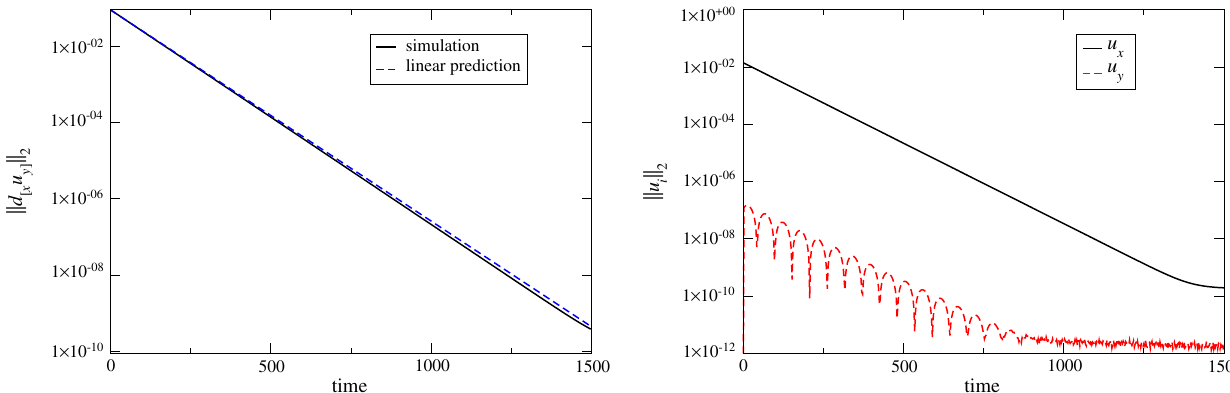
FIG. 4. L norms of (a) vorticity and (b) u 2 ¼ 10 7 , v ¼ 0 : 02 , D ¼ 10 , n ¼ 10 decay ( (cid:1) 0 0